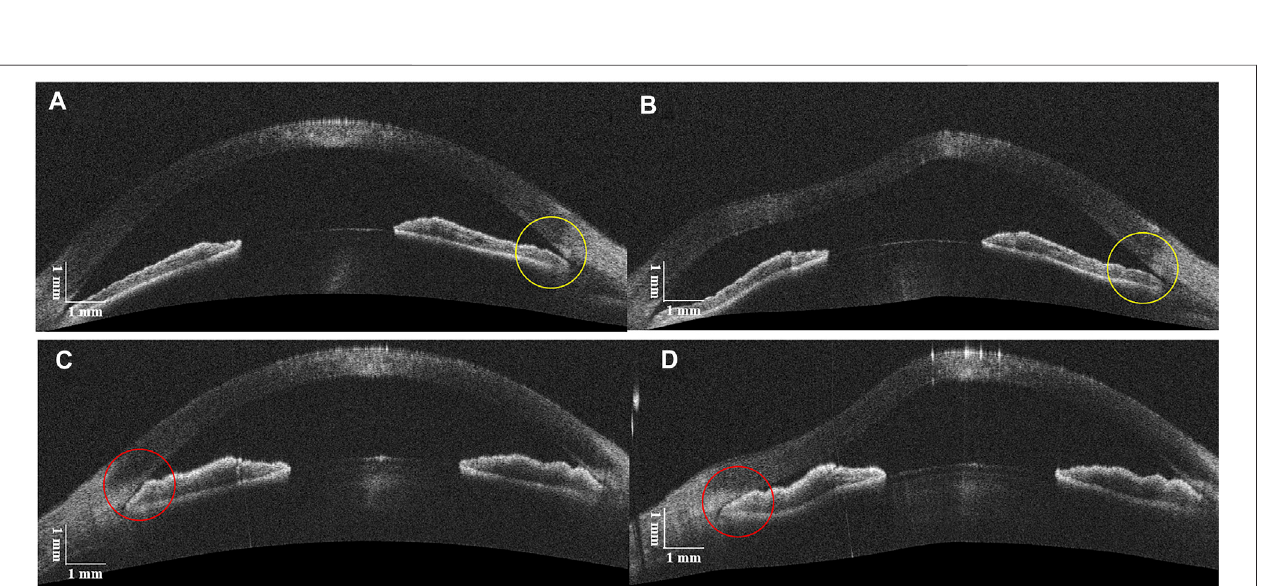
TABLE 1 | Structural parameters on both sides of the ACA in normal subjects. AOD750 before /mm